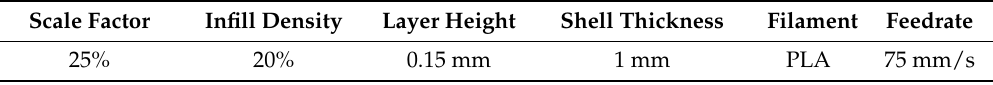
Figure 7. Computer Assisted Design (CAD) model of Medieval Castle available at https://www.thingiverse.com/thing:884536. The full-scale height of the Castle is 457 mm. However, it is printed at 25% scale factor. Table 8. Key parameters used in Cura for slicing the Medieval Castle.